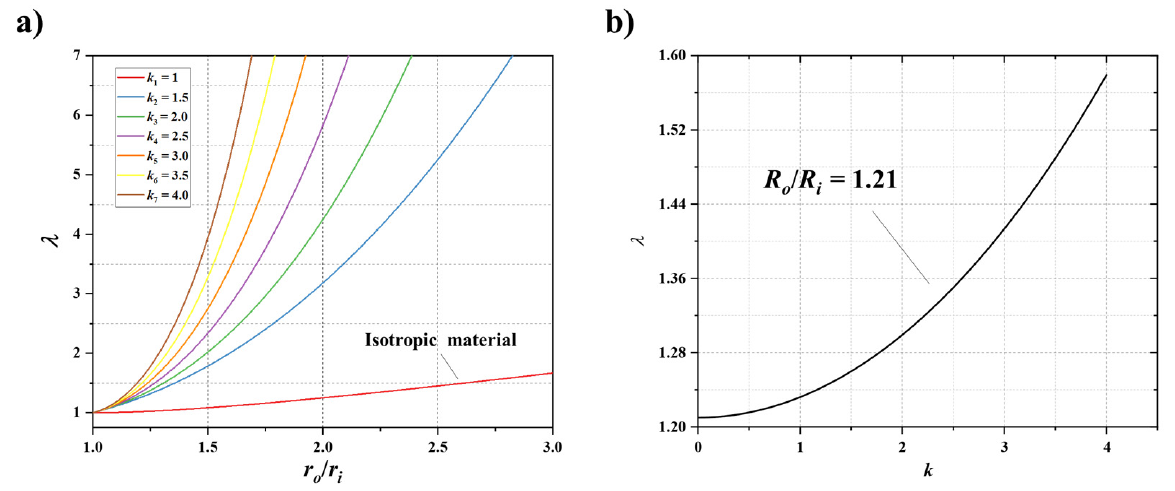
Figure 7. ( a ) Relationship between λ and r o / r i under different k ; ( b ) relationship between λ and k when r o / r i = 1.21.